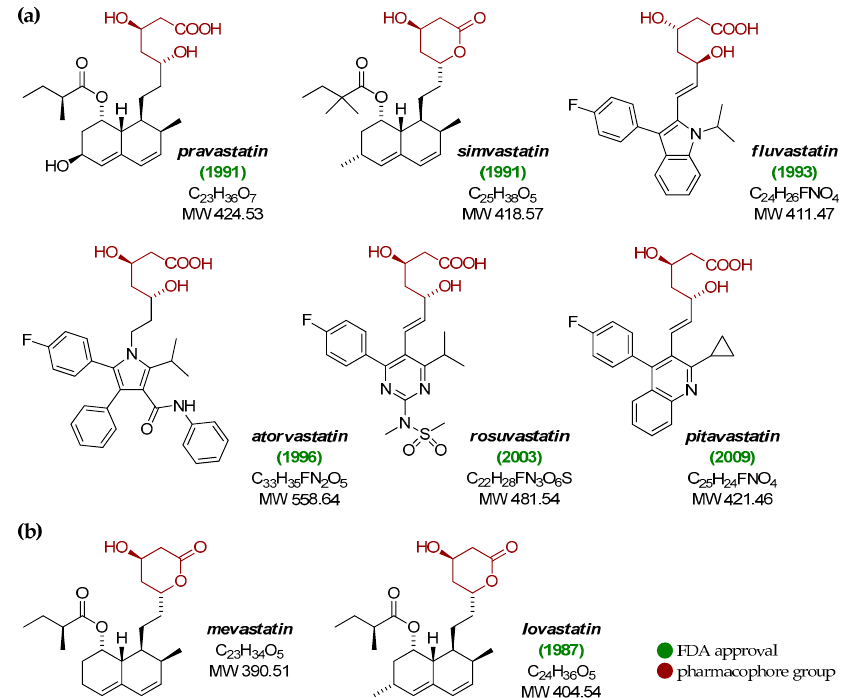
Figure 1. The structure of ( a ) six currently marketed statins, and ( b ) mevastatin (compactin) and lovastatin (mevinolin), the first two isolated and known statins. Both mevastatin and lovastatin are naturally-occurring statins, pravastatin is derived from mevastatin via biotransformation process, simvastatin is a semi-synthetic analog of lovastatin, while fluvastatin, atorvastatin, rosuvastatin and pitavastatin are fully synthetic compounds from the statins class.